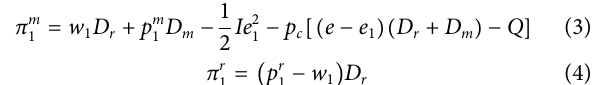
TABLE 1 | Notations. Parameters De fi nition D r Demand of traditional retail channels D